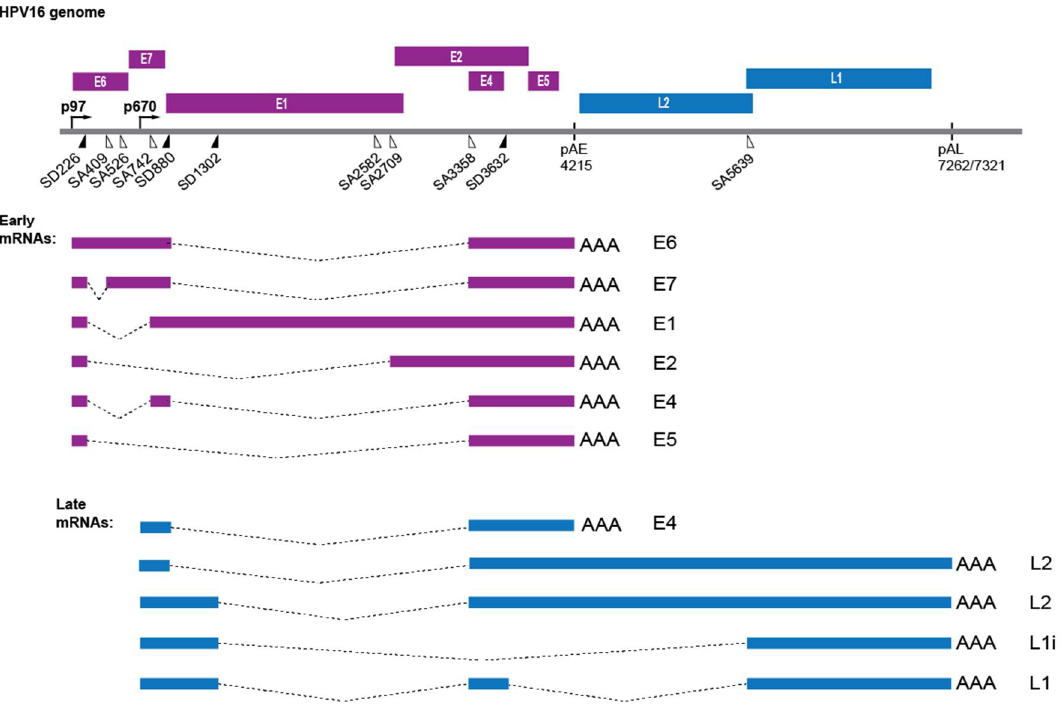
Figure 1. Schematic representation of the HPV16 genome. HPV16 early genes E1, E2, E4, E5, E6 and E7 and HPV16 late L1 and L2 genes are indicated. HPV16 early promoter (p97), late promoter (p670) and early (pAE) and late (pAL) polyadenylation signals are shown. Filled triangles represent 5′-splice sites and open triangles represent 3′-splice sites. Splice sites SD226, SA409, SA526 and SA742 are used exclusively by early mRNAs; SD3632 and SA5639 are used exclusively by late mRNAs; and splices sites SD880, SD1302, SA2582, SA2709 and SA3358 are used both by early and late mRNAs. A subset of HPV16 alternatively spliced early mRNAs and late mRNAs are shown.